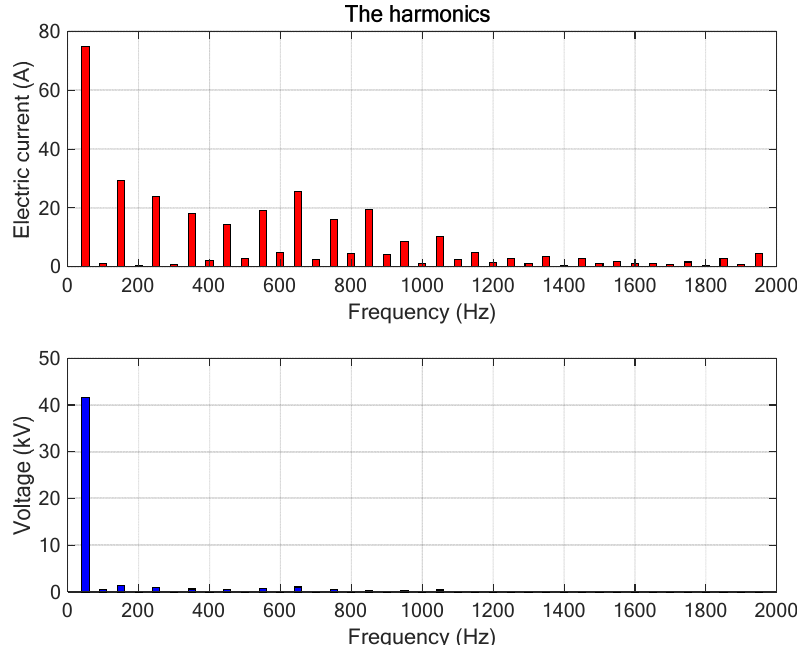
Figure 3. The harmonics of the current and voltage in the power supply station.